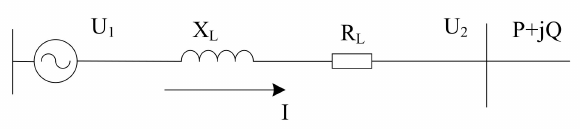
Figure 1. Electric heating voltage reduction schematic